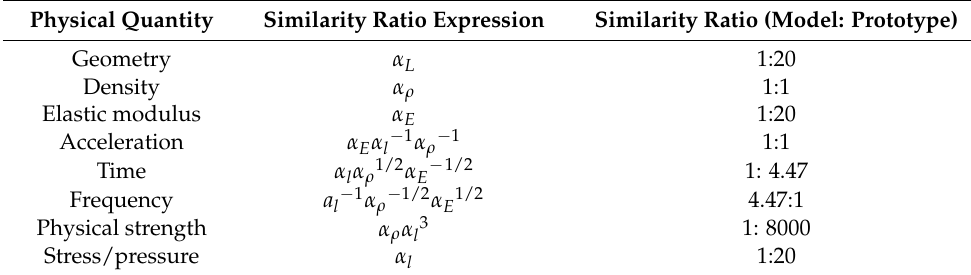
Table 1. Similarity ratio of each physical